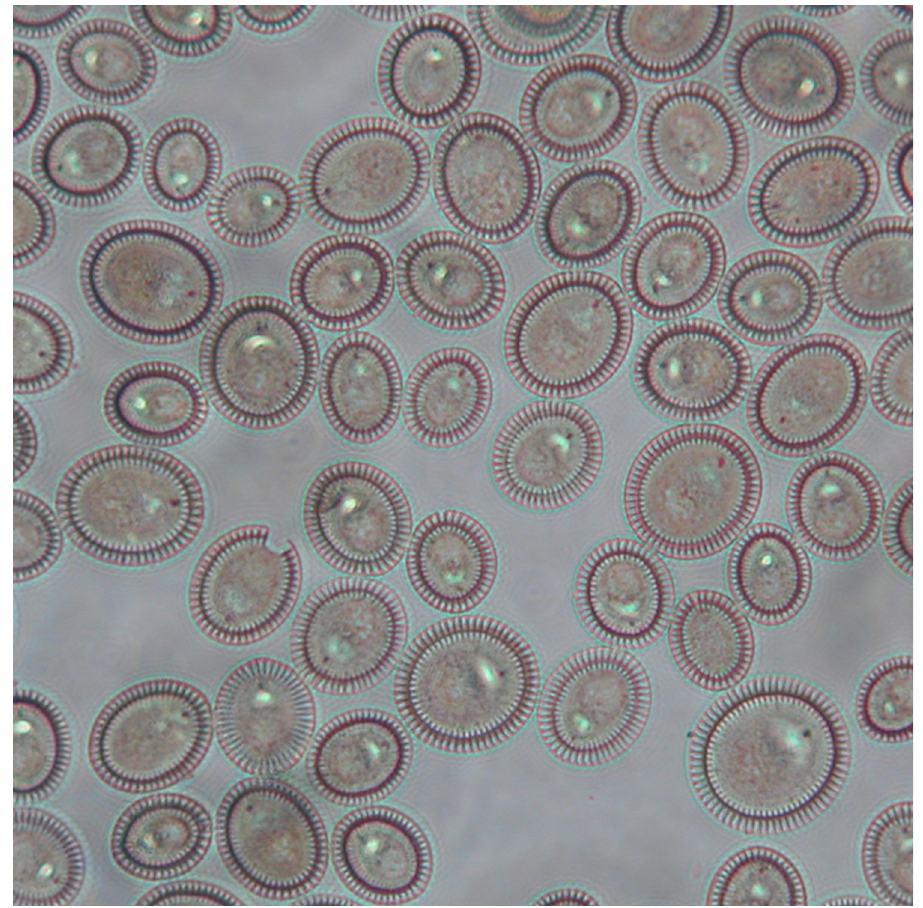
Fig 1. Example of a purified diatom sample (under light microscope) following the use of this protocol. Sample from Lake El’gygytgyn, Russia